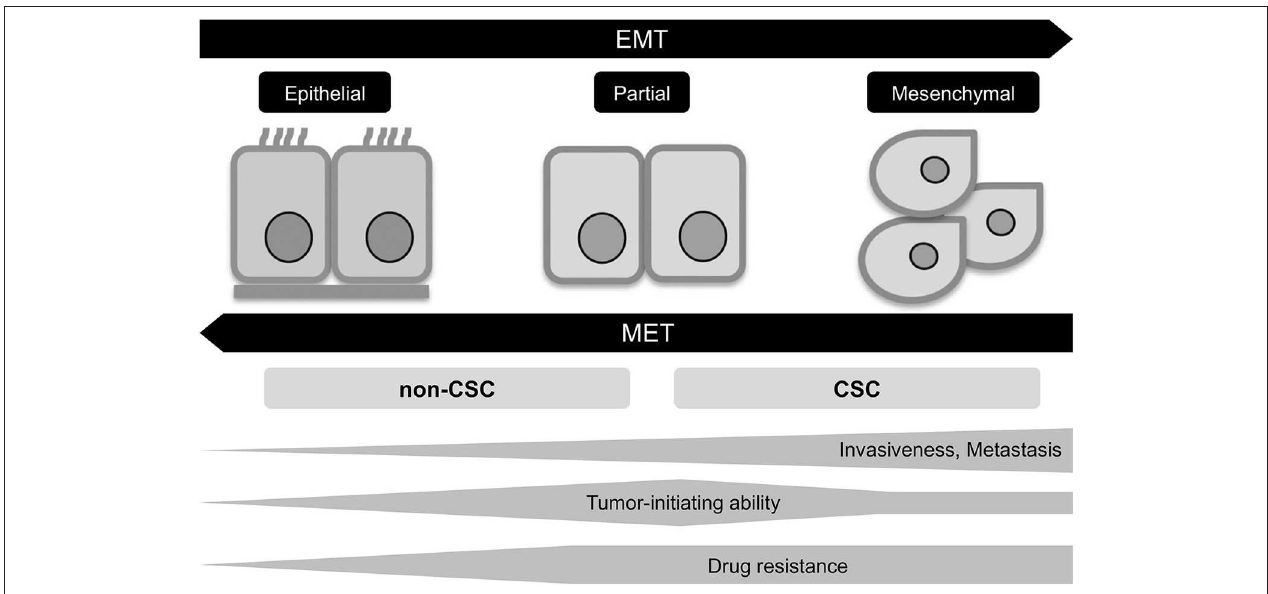
FIGURE 3 | EMT program in tumor progression. EMT, epithelial-mesenchymal transition; MET, mesenchymal-epithelial transition; CSC, cancer stem cell.